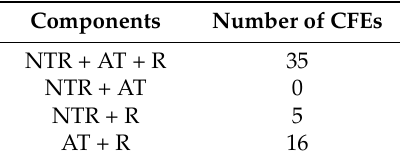
Table 1. Number of coastal flooding events (CFEs) predicted using different combinations of local sea level (TWL) components.